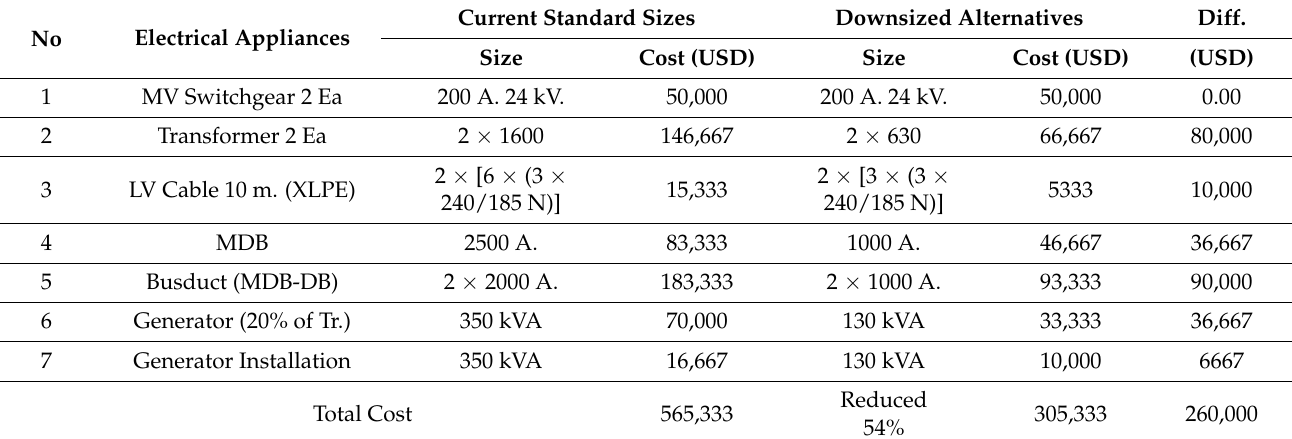
Table 4. Comparison of two sizes of electrical appliances for cost effectiveness